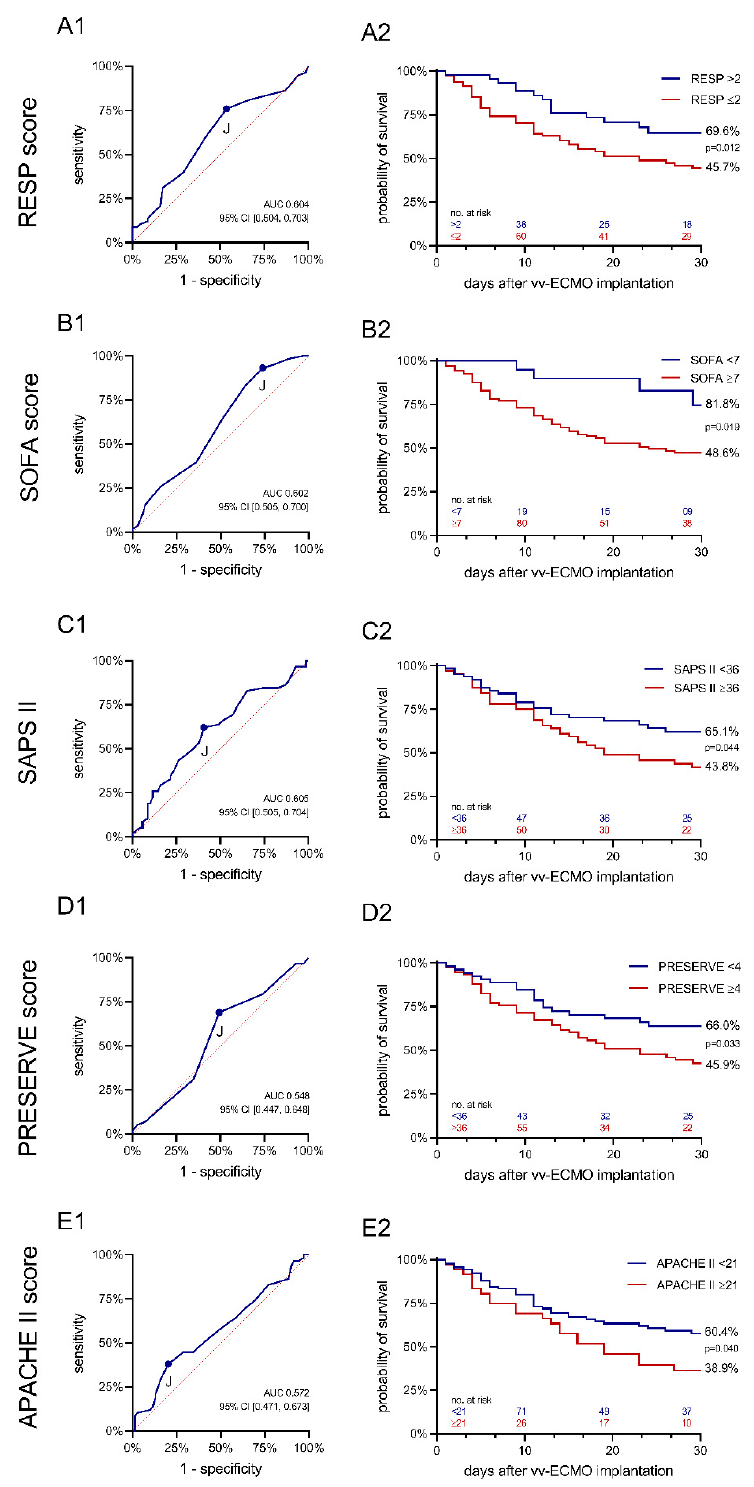
Figure 3. Receiver operating characteristic (ROC) analyses for the scores analyzed and Kaplan-Meier curves displaying the survival in the groups above and below the cut-off values, respectively, over the course of the 30-day study period. A1: ROC analysis RESP score. A2: Kaplan-Meier curve RESP score. B1: ROC analysis SOFA score. B2: Kaplan-Meier curve SOFA score. C1: ROC analysis SAPS II. C2: Kaplan-Meier curve SAPS II. D1: ROC analysis PRESERVE score. D2: Kaplan-Meier curve PRESERVE score. E1: ROC analysis APACHE II score. E2: Kaplan-Meier curve APACHE II